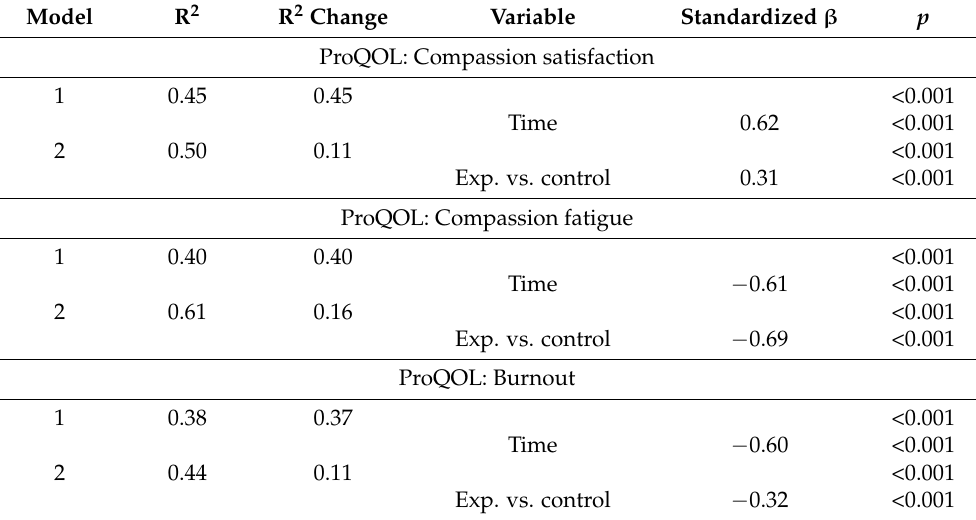
Table 2. Summary of multiple linear regression analyses predicting subject variables, including the three subscales (ProQOL). Controlling for the effect of comparing the experimental group with the control group after controlling for